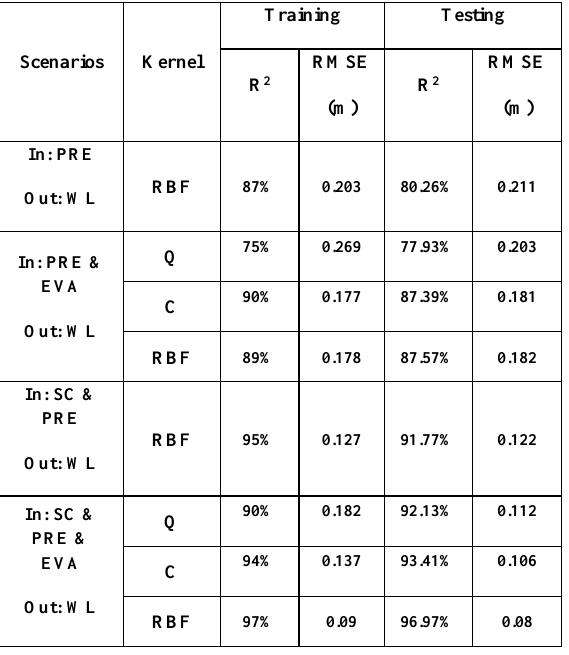
Table 2. The results of training and test